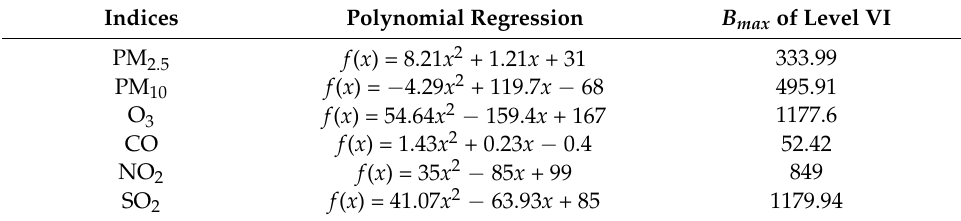
Table 11. Polynomial regression for B max of all criteria with level VI.